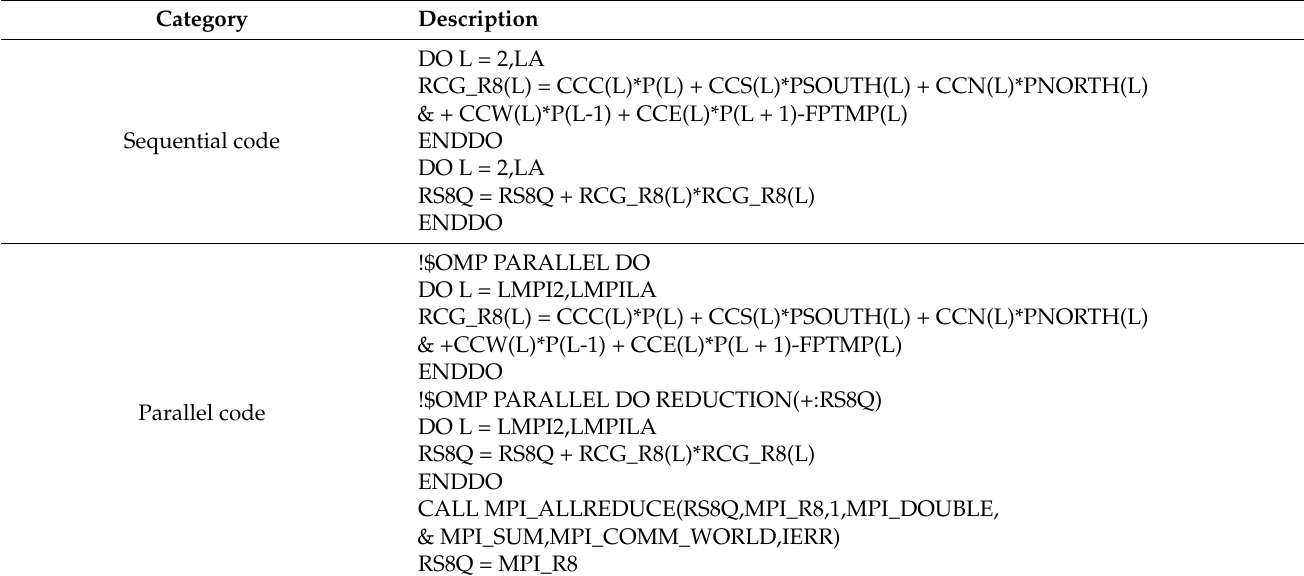
Table A2. Example of hybrid parallel code